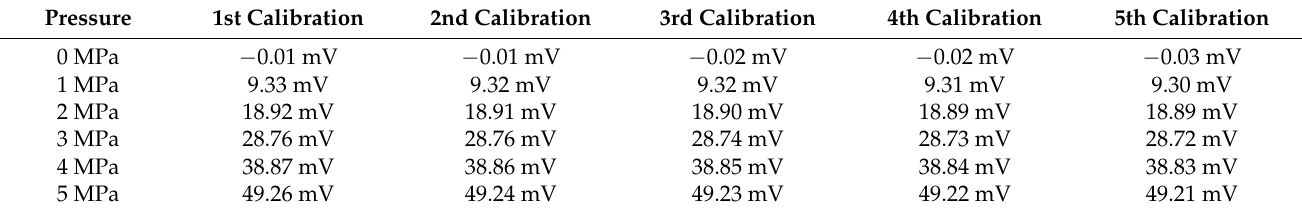
Table 3. Static performance index Table 2. Sensor ’s output voltage in static calibration.